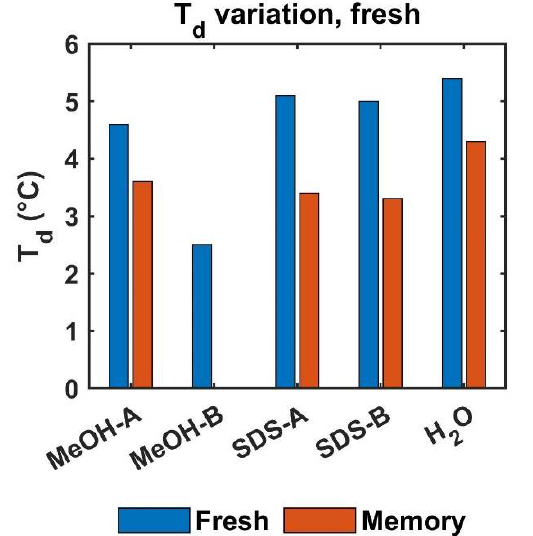
Figure 11. Illustrated T d measurement for different chemicals during SCR using rocking cell setup.